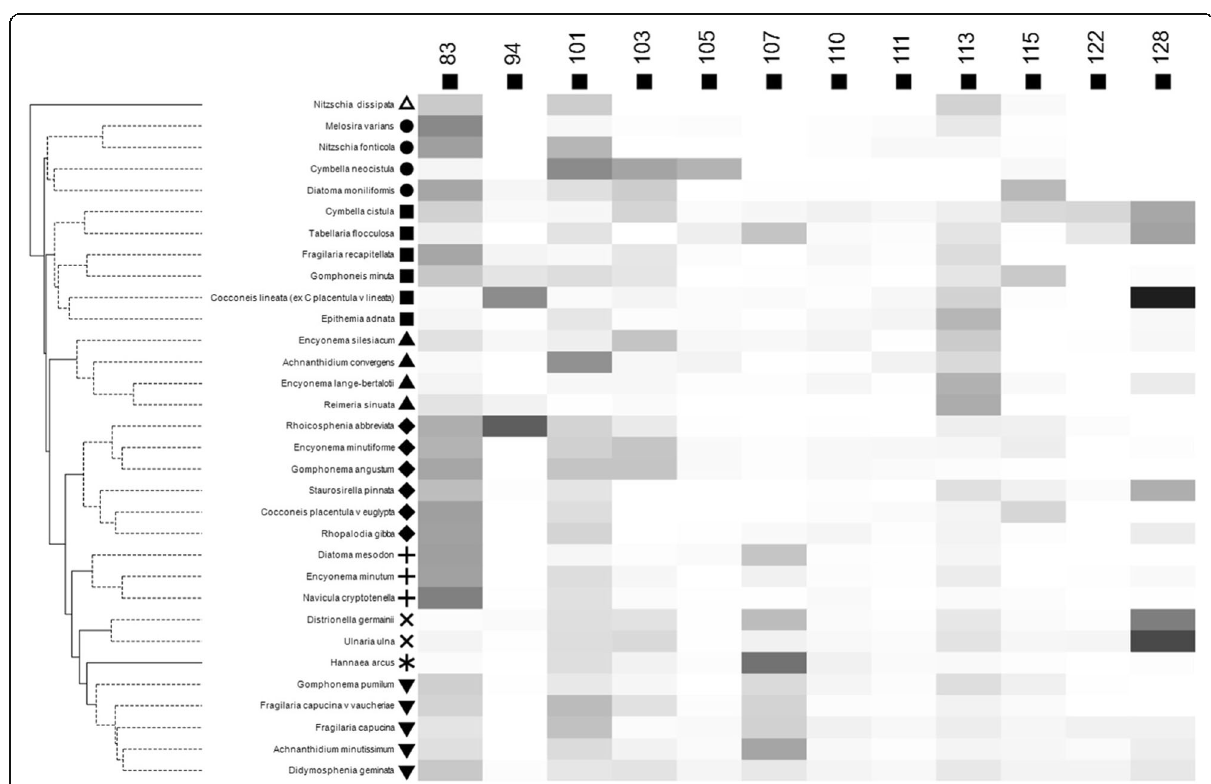
Fig. 7 Shade plot showing the distribution of density of the species (listed at the left) with the greatest contibution to the structure of the groups of sites invaded by D. geminata in the studied basins (numbers above the graph). The left side of the figure show the clustering with the significant groups (dashed lines) identified by SIMPROF. Biobio River Basin (83), Tolten River Basin (94), Valdivia River Basin (101), Bueno River Basin (103), Puelo River Basin (105), Yelcho River Basin (107), Palena and coastal Rivers in the Southern Limit of the Tenth Region River Basin (110), Coastal and Island Rivers Between Palena River and Aysen River Basins (111), Aysen River Basin (113), Baker River Basin (115), Coastal Rivers Between Seno Andrew and Hollemberg River and Rivers to the East River Basins (122), and Tierra del Fuego (128). (DG+/ − ) species was present in invaded and no invaded sites, (DG+) species presents only in invaded